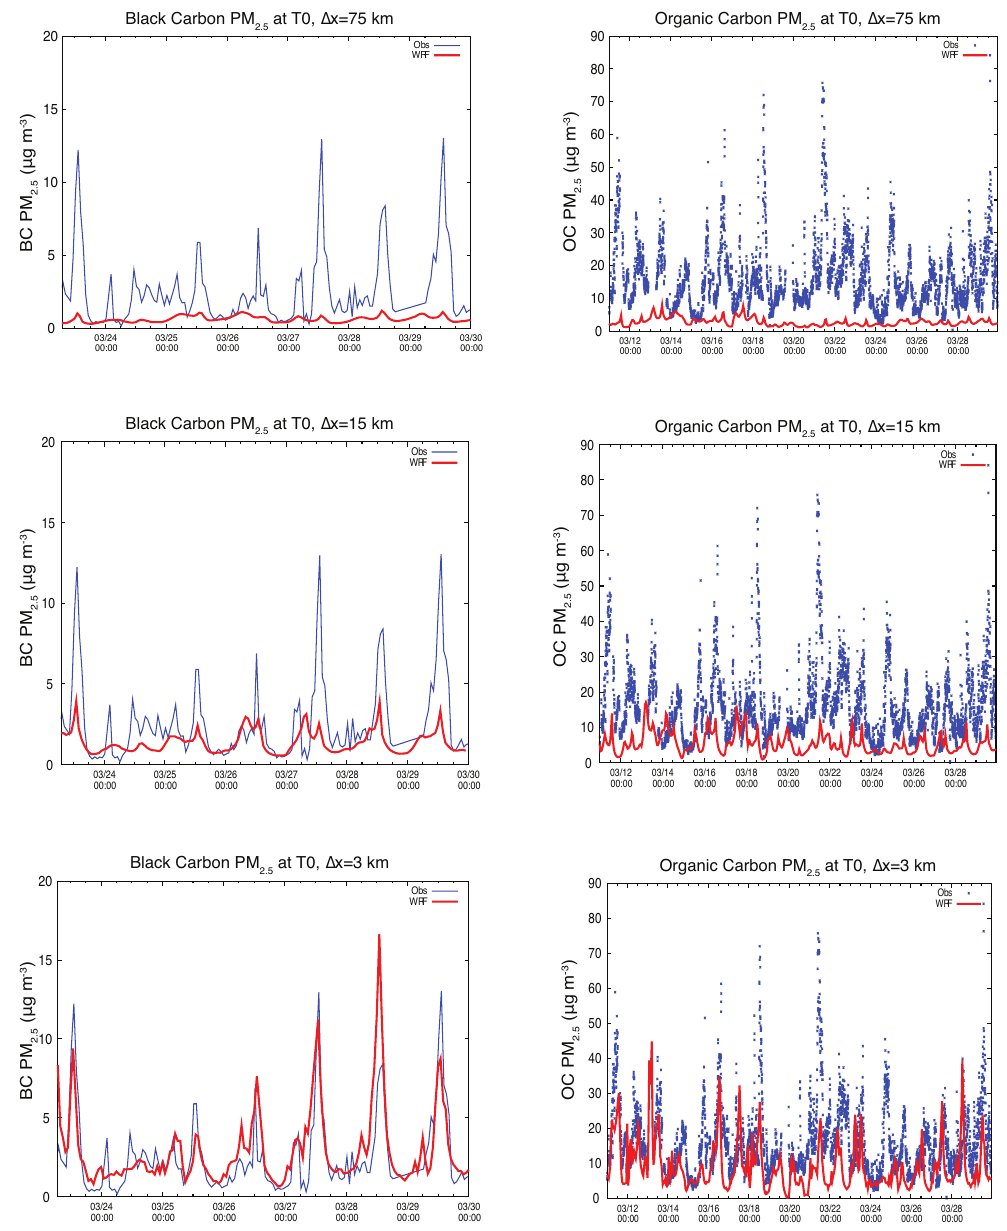
Fig. 7. Time series at site T0 of observed (blue) and simulated (red) surface concentration of BC (left column, unit: µgm − 3 ) and OM (right column, unit: µgm − 3 ) for 75-km (top), 15-km (middle), and 3-km (bottom) simulations, respectively.